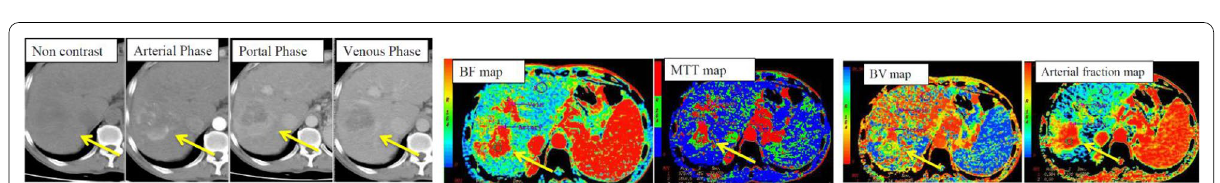
Fig. 3 53-year-old male patient with liver cirrhosis and right hepatic lobe segment VII/VIII HCC underwent radiofrequency ablation on January 2019. Follow-up post-intervention triphasic CT was done on February 2019 and revealed evident intra-lesional pathological enhancement, denoting residual/recurrence activity of this lesion. CTP functional maps showed marked increase in blood flow to the lesion measuring about 233 mL/100 g/min compared to 67 mL/100 g/min in the rest of hepatic parenchyma. In addition, the mean transit time is reduced to become 6